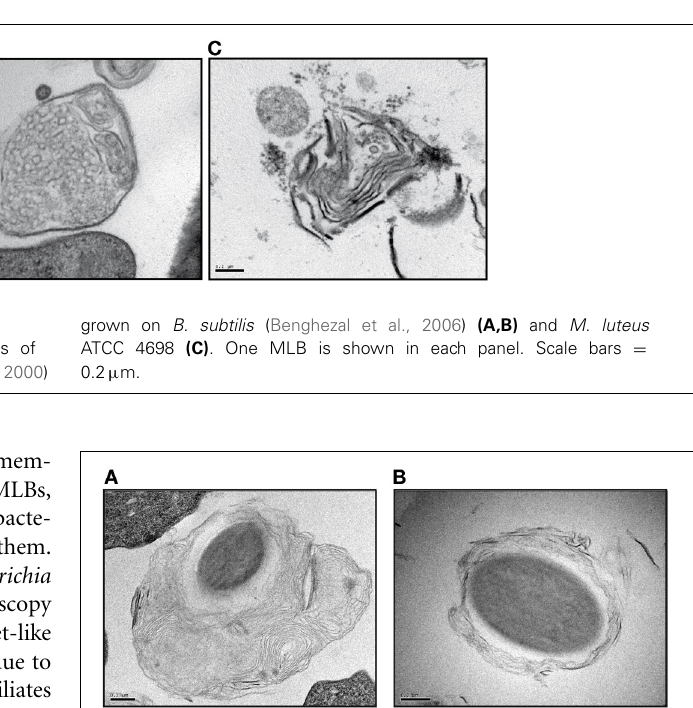
FIGURE 3 | D. discoideum cells can package polystyrene beads in secreted MLBs. Transmission electronic micrographic images of polystyrene beads packaged in thick (A) and thin (B) MLBs after being incubated with D. discoideum DH1-10 cells (Cornillon et al., 2000) in the presence of digestible bacteria. Scale bars = 0.2 µ